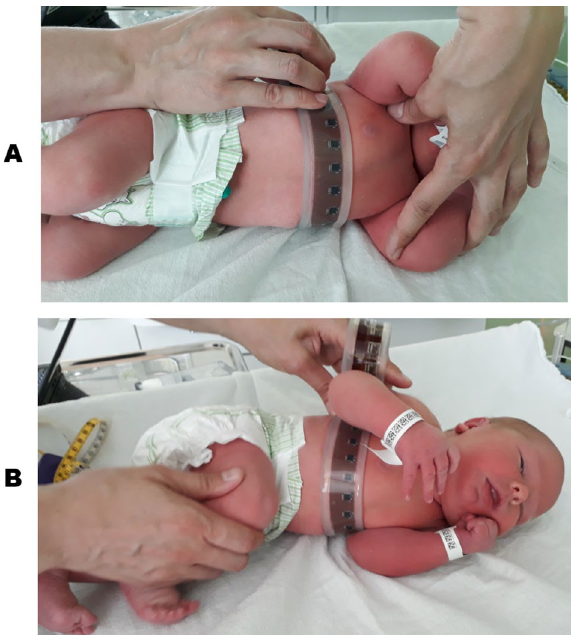
Figure 1. The electronic measuring belt applied on one of the recruited subjects in the maternity ward. According to the protocol, in this shot the clinician was recording the torso shape of the baby lying on his left side with his arms up ( A ) and down ( B ). The photographs are published with permission of both of the baby’s